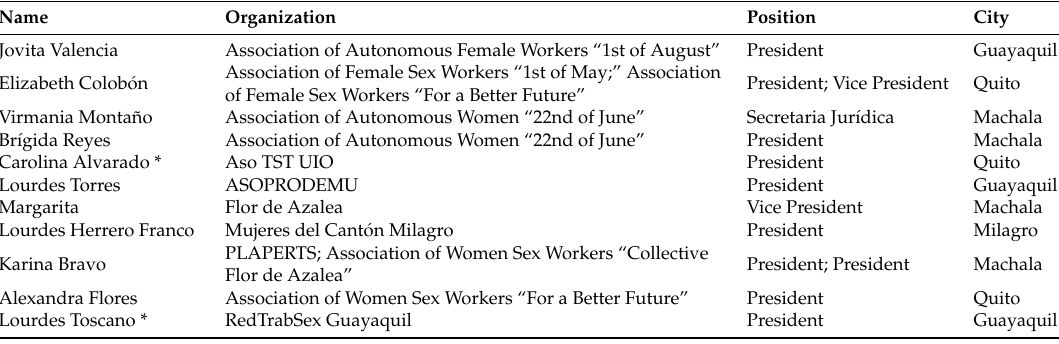
Table A5. Interviews with sex workers’ organizations in Ecuador.